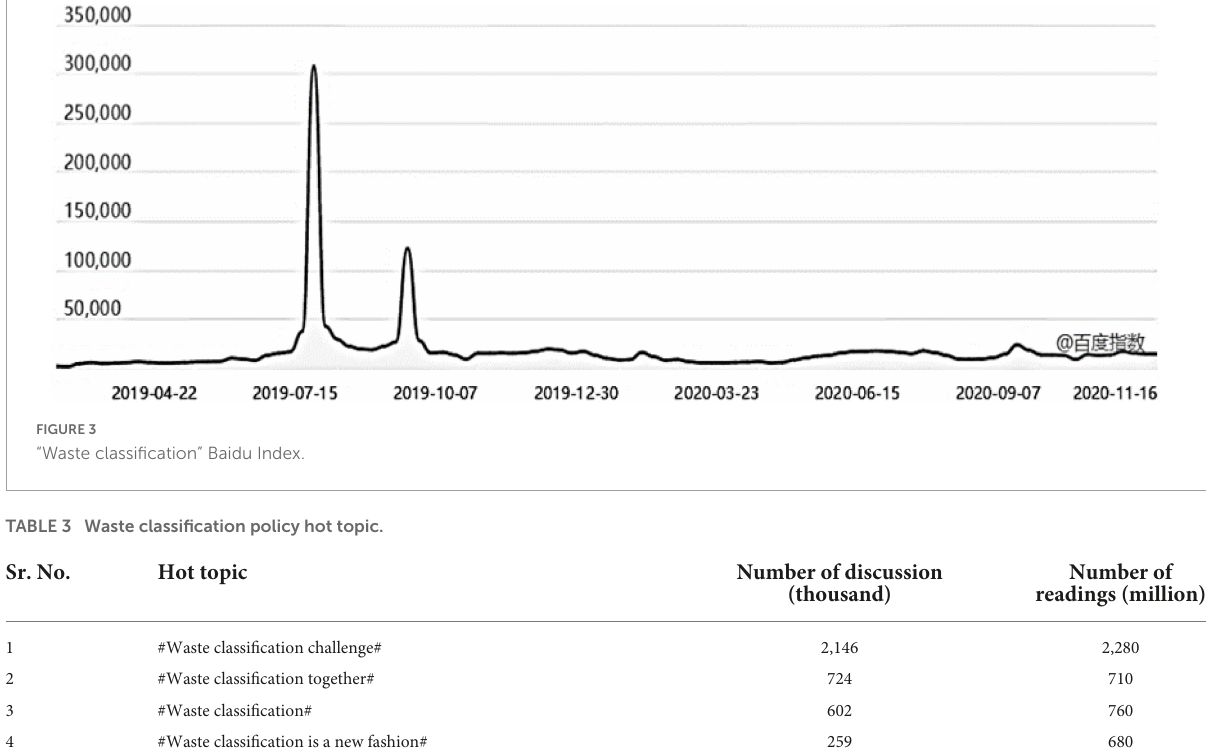
TABLE 3 Waste classification policy hot